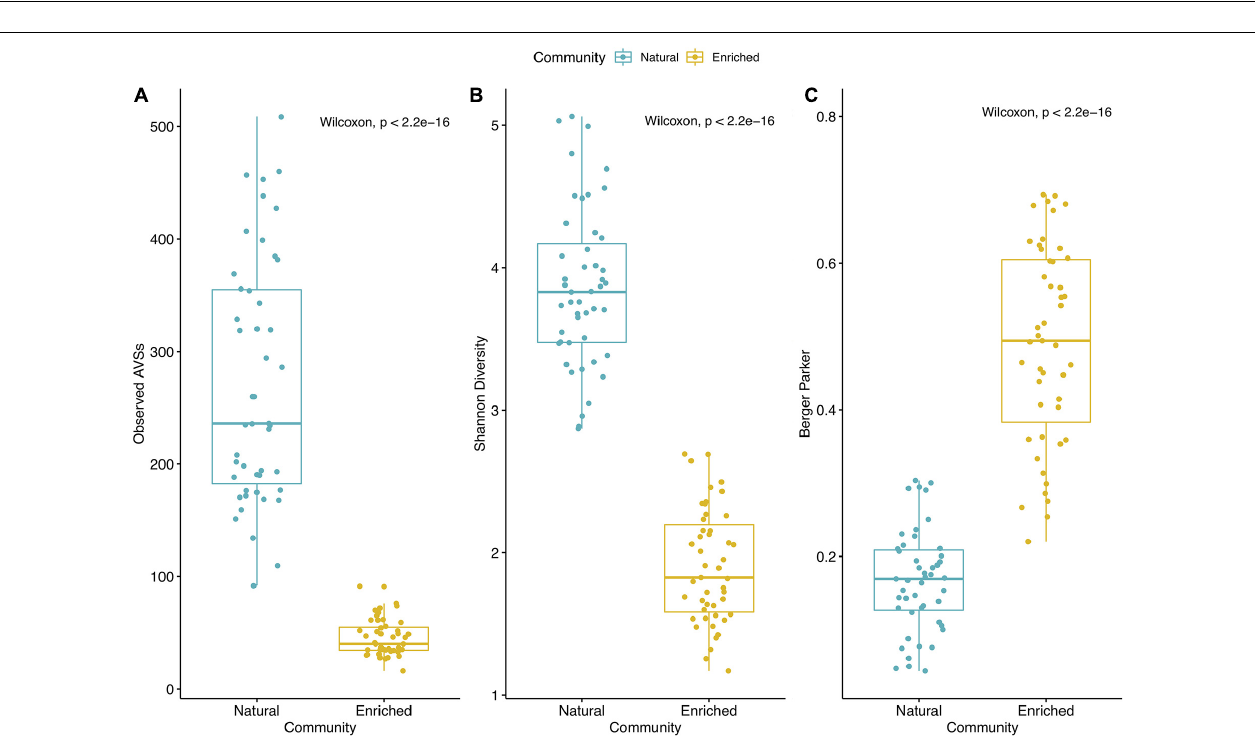
FIGURE 2 | Alpha rarefaction curves of natural and enriched microbial communities of 47 sampling sites.